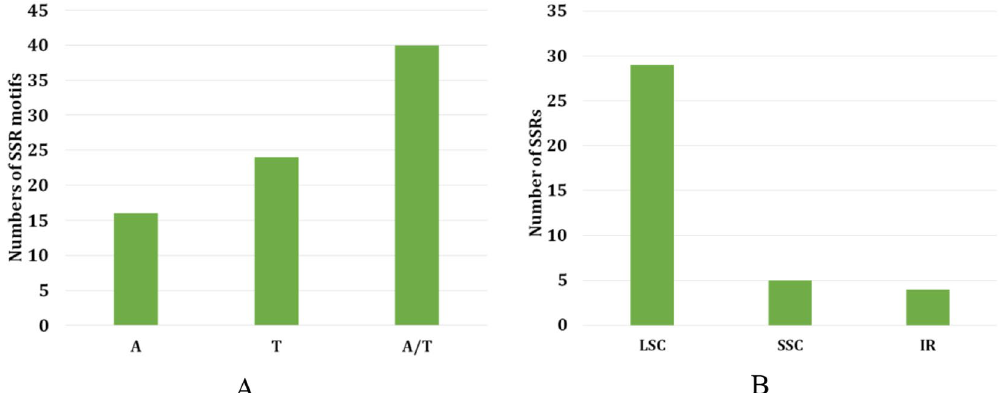
Figure 2. Analysis of single sequence repeats of plastome in A. megaphylla Hu. ( A ) Number of identified SSR sequence motifs; ( B ) Frequency of repeat types in LSC, SSC, and IR regions.